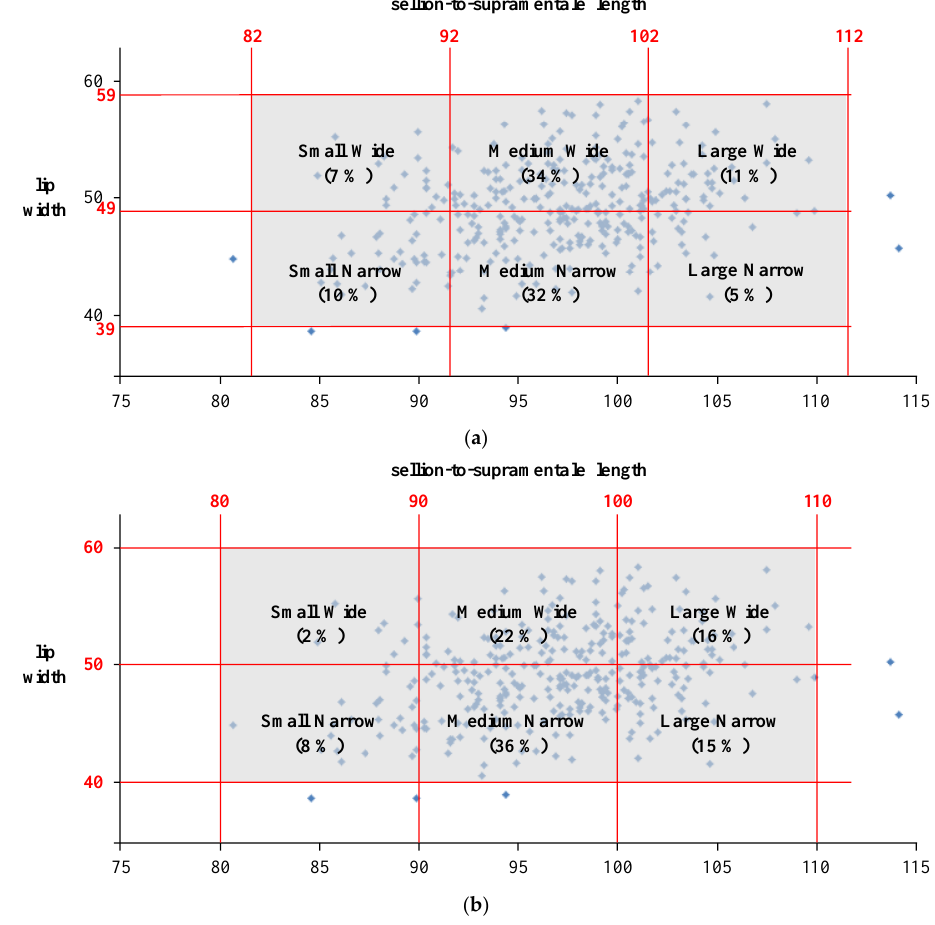
Figure 3. Generation of a revised oxygen mask sizing system for KAF pilots. ( a ) initial sizing system (accommodation percentage = 98%); ( b ) adjusted sizing system (accommodation percentage = 99%).